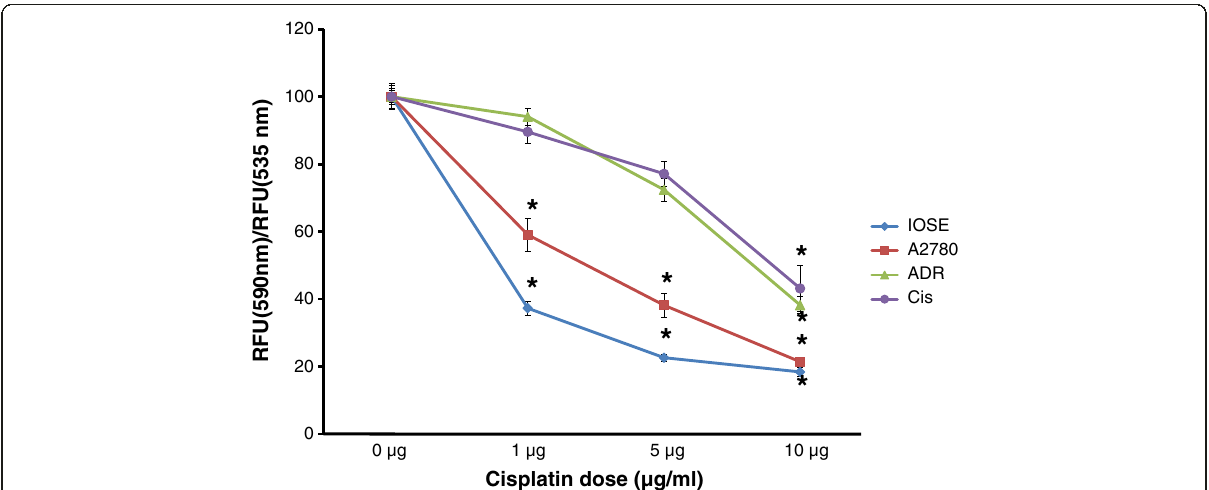
Figure 3 Quantification of cell death by JC-1 analysis (red/green fluorescence ratio) with 3 doses of Cisplatin (1, 5 and 10 μ g) for 48 hours. Values represent means for each group ± SEM (* p < 0.001 one way ANOVA and